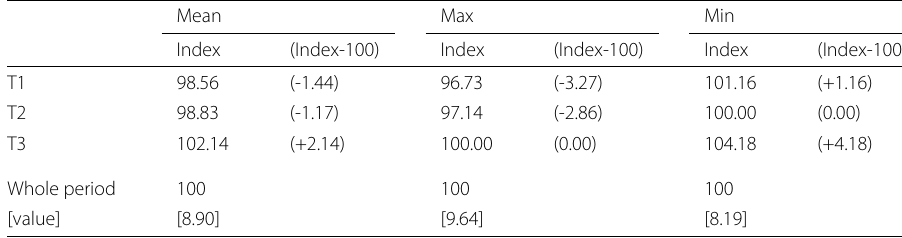
Table 5 Largest eigenvalue index by sub-period